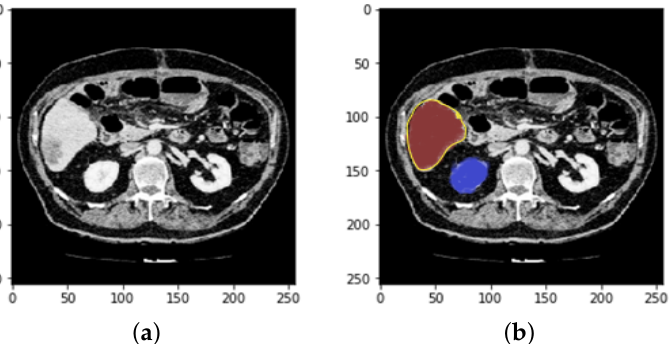
Figure 3. Prepocessing state of CT image ( a ) after HU windowing and ( b ) using ResUNet Segmentation.